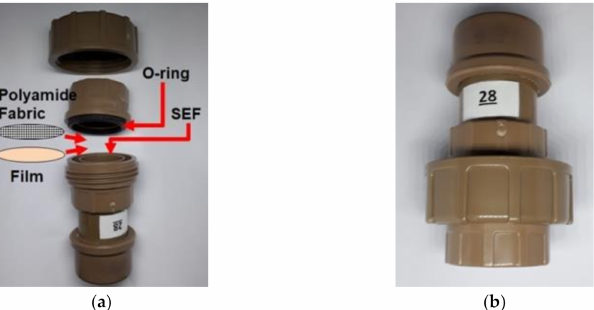
Figure 1. Modified Paddington cups for the determination of fluid handling capacity (FHC) ( a ); cups in inverted position ( b